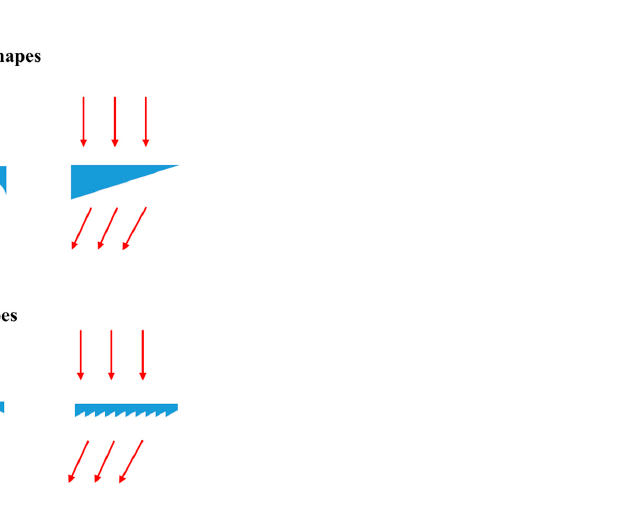
Figure 1. ( a ) Shows three examples of static beam steering or lensing devices. Here left and middle figures show focusing and defocusing lenses, respectively. The right-hand side shows a simple deflecting prism. ( b ) Shows the refractive Fresnel equivalents of the structures shown above. Of particular importance to describe NLC optics are Gradient Index (GRIN) effects.